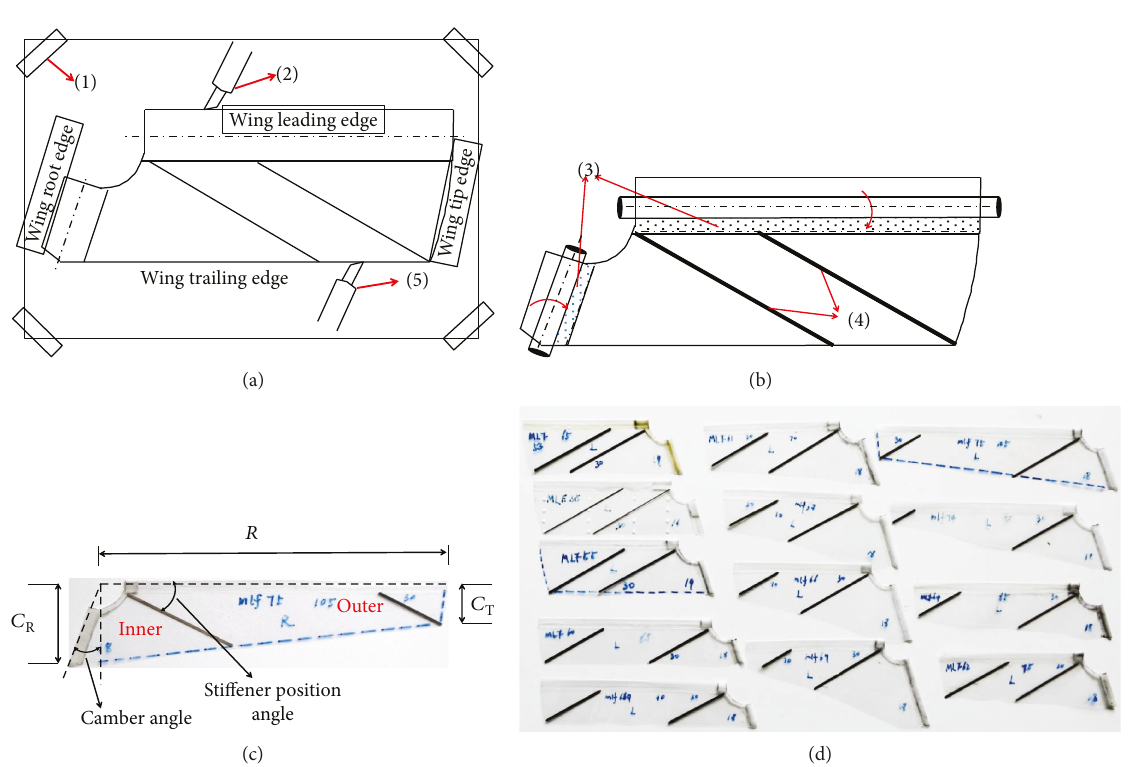
Figure 12: Principal steps of wing production and certain selected wings. (a) – (b): (1) mylar foil is taped on top of a printed template with desired wing geometry. (2) The contours of future wing sleeves are cut out. (3) Strips of Te fl on are placed at the position of wing bars and fi xed. Glue (Pattex contact glue diluted 1:1 with acetone) is applied, and the sleeves are completed by folding the foil around the Te fl on strips. (4) Glue is applied at the position of sti ff eners and the sti ff eners are glued. (5) The rest of the wing is cut out, and the Te fl on strips are removed. (c) Wing geometry: C wing tip chord and C wing root chord. (d) Certain selected wings T R